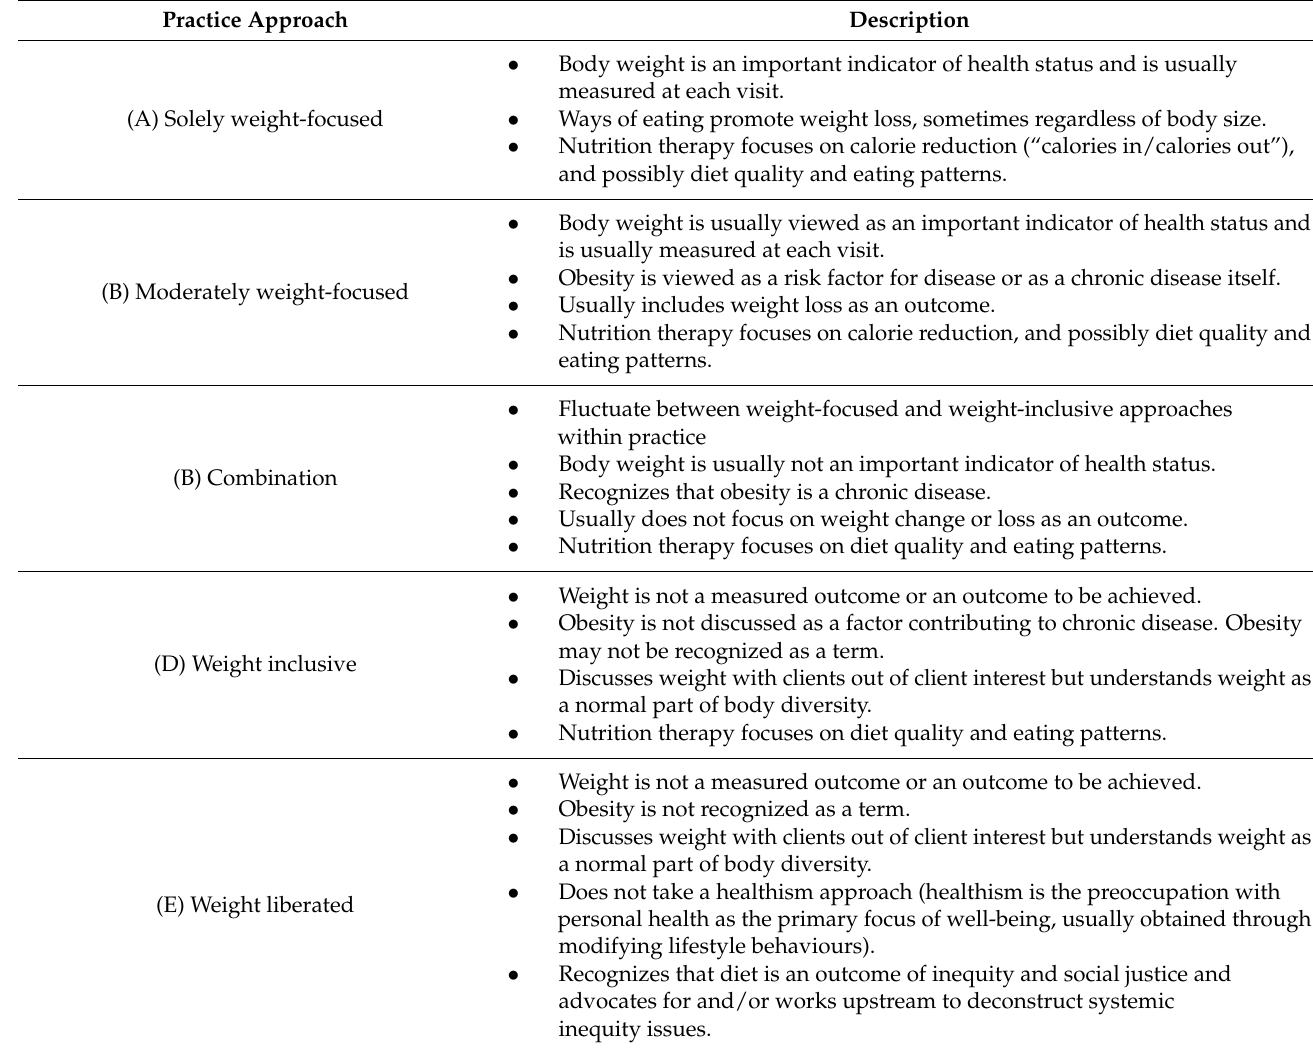
Table 1. Practice approach classification framework a